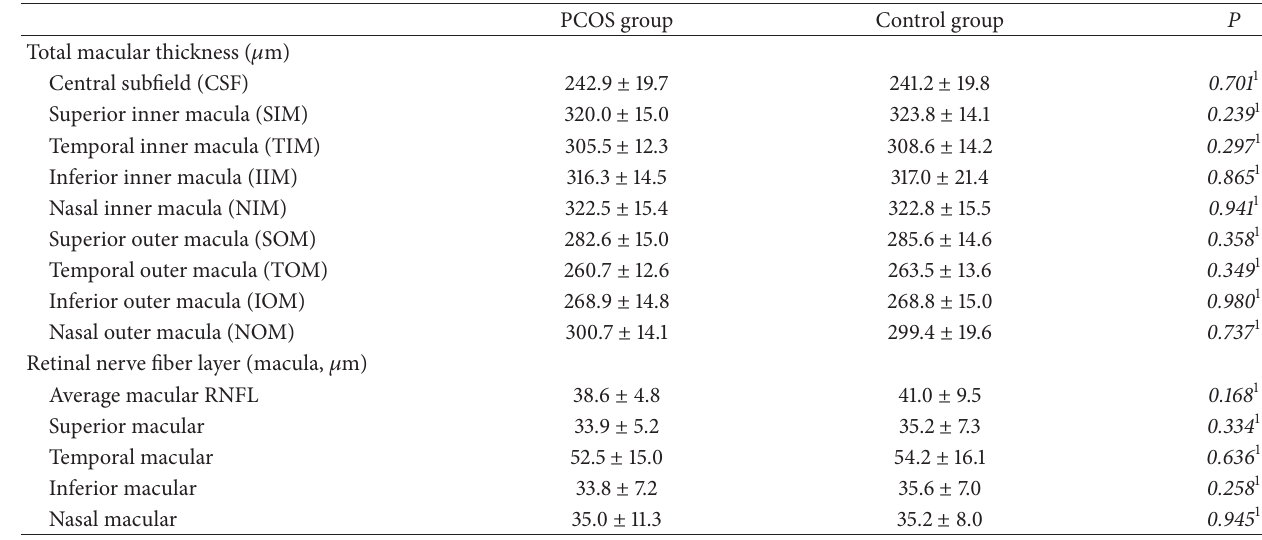
Table 2: Total macular thickness and RNFL in the macular region using HD-OCT: comparison between PCOS and control groups. PCOS group Control group